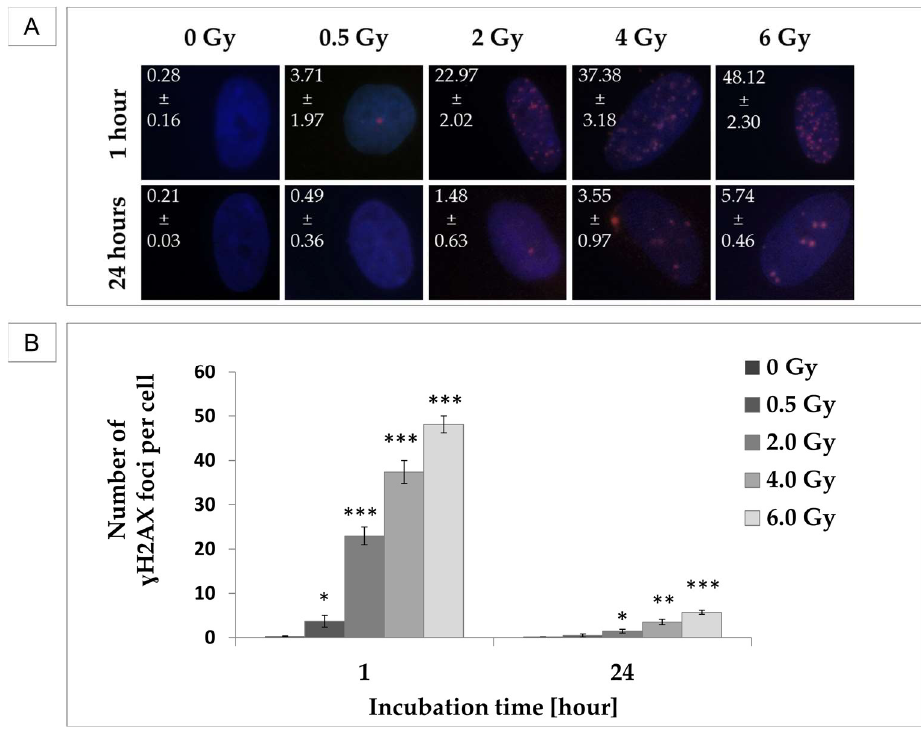
Figure 6. dsDNA-damaging effects of irradiation (IR) on pADSCs and their repair capacity within 24 h. Phosphorylated H2AX (γH2AX) was used as a marker for DNA double-strand breaks (DSBs). To determine γH2AX foci, cells were fixed 1 h or 24 h after IR and incubated with anti-γH2AX antibody and IgG1 (red); DNA counterstaining with 4,6-diamidino-2-phenylindole (DAPI) (blue). ( A ) Exemplary images of immunocytochemistry staining at different time points after IR. On the left corner of each image, results are illustrated as mean ± standard deviation (SD, n = 3); ( B ) Graphical illustration of mean number of γH2AX foci per cell; asterisks illustrate significant differences to unirradiated cells (control): * p < 0.05; ** p < 0.01; *** p < 0.001.